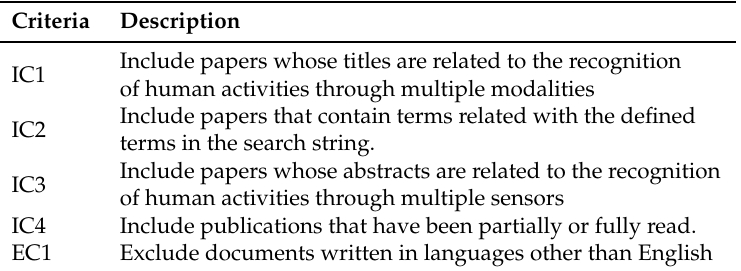
Table 3. Inclusion and exclusion criteria.